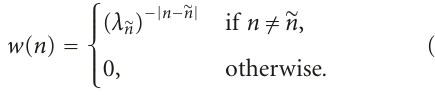
represents the common set of detectors of B m and B s and we consider them as truly band ring generating detectors. Then for every value of the set B , the corresponding range of the contiguous stripes is determined from B s . Finally, the unique stripe positions for both the single (as determined for M = 1 in the previous stage) and contiguous stripes are the total corrupted locations in the